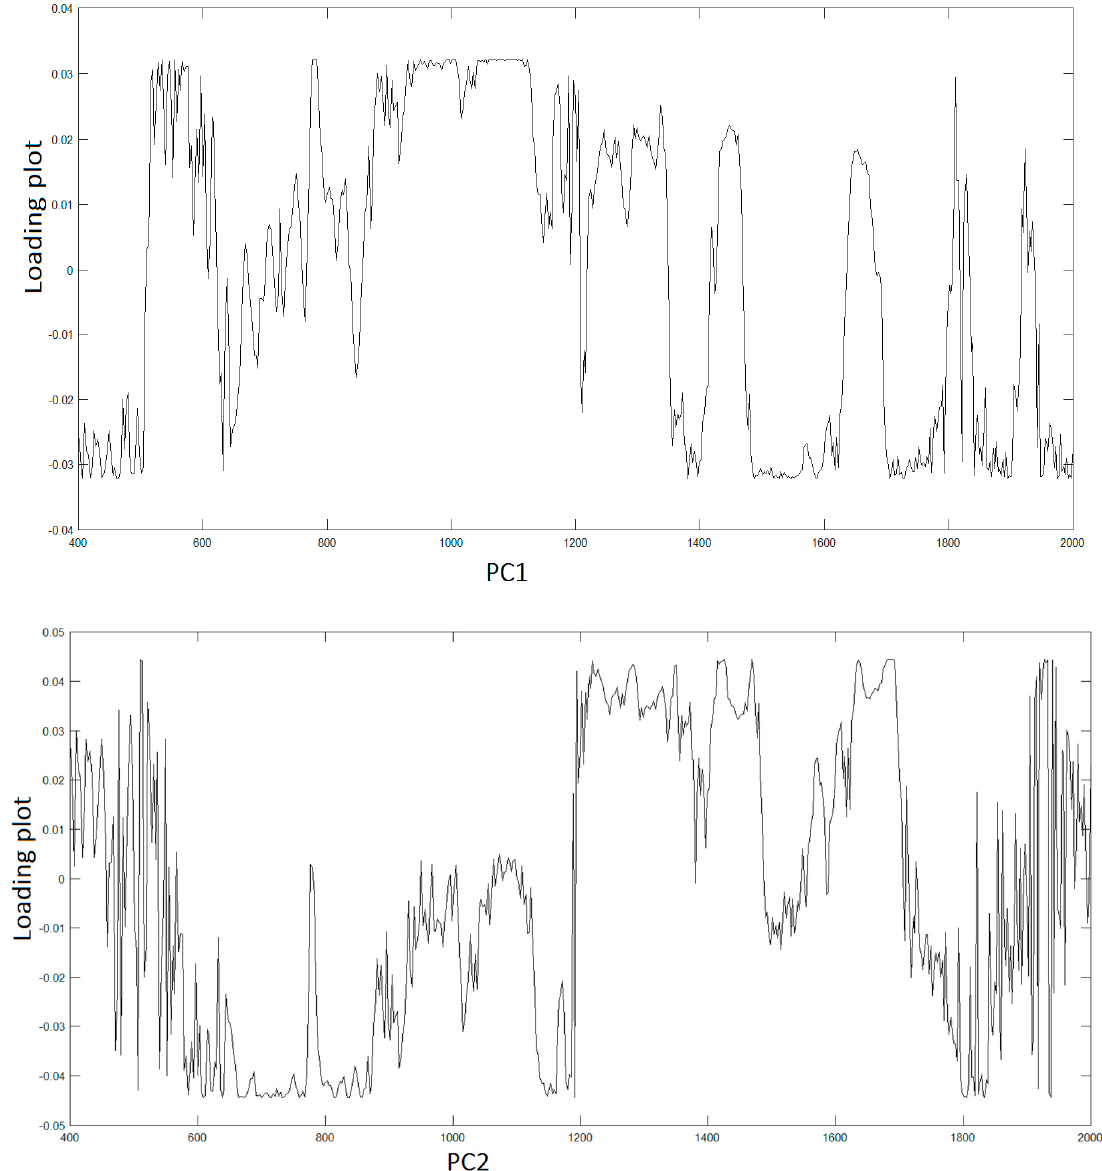
Figure 3. First two principal component (PC)1,2 loading plots.